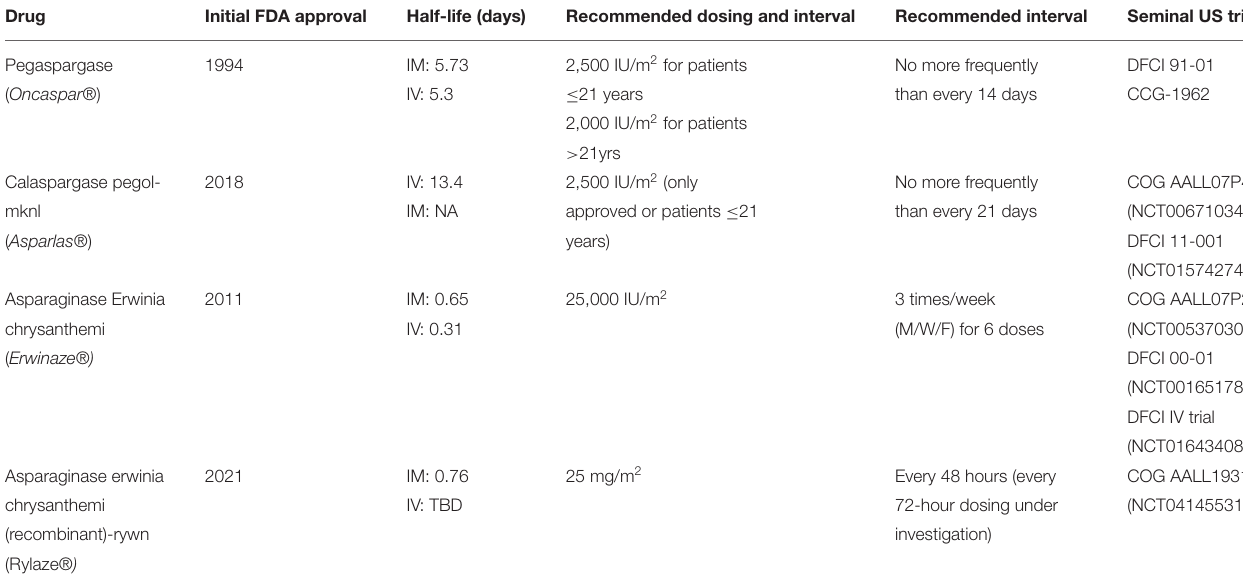
TABLE 1 | Asparaginase formulations.